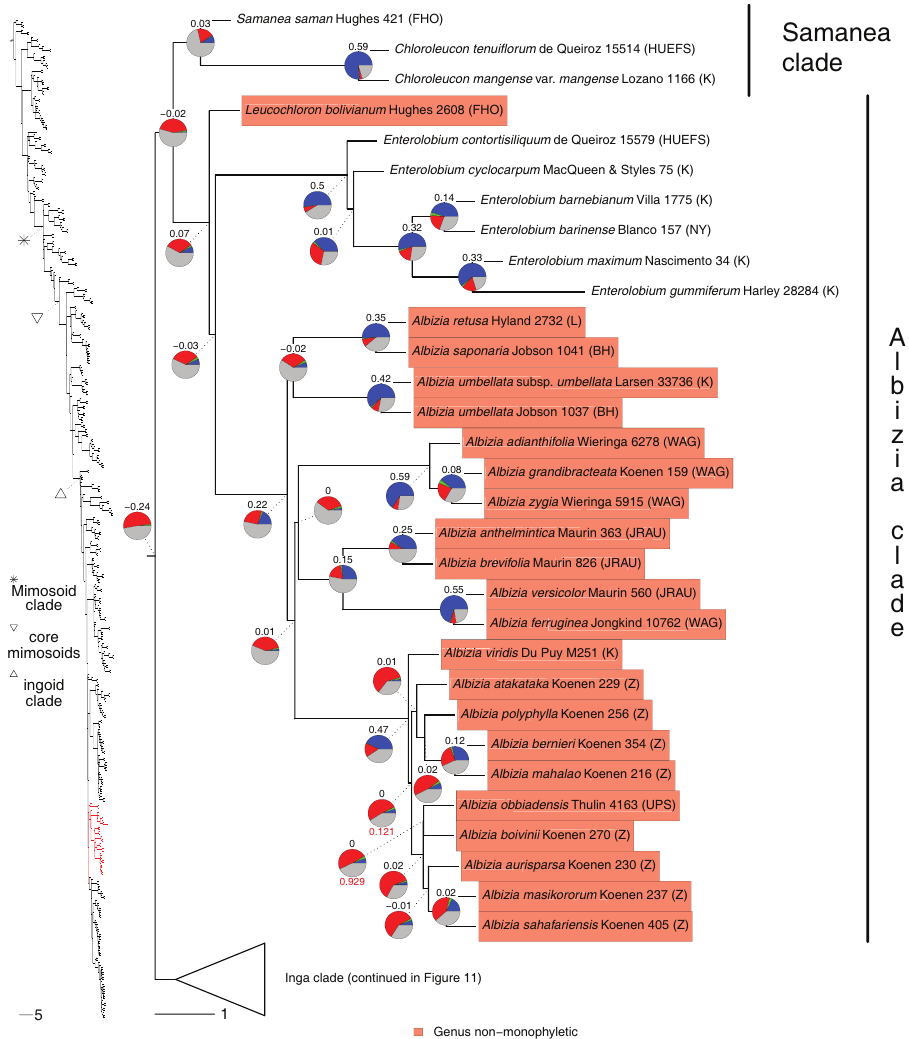
Figure 10. Phylogeny of Caesalpinioideae (continued). See Fig. 2 for